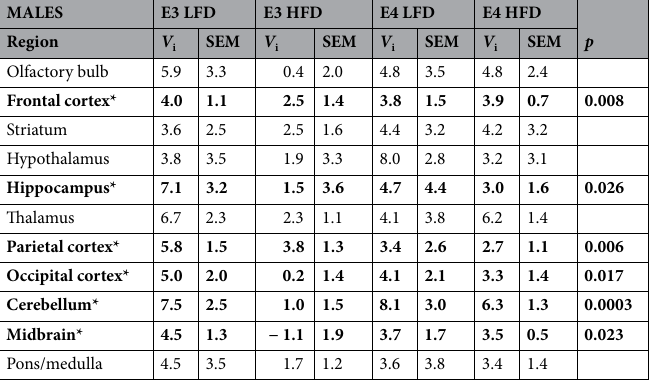
Table 1. 125 I-insulin regional vascular binding in males. Bold cells represent regions where * p < 0.05 between groups. V i : reversible vascular binding, SEM: ± standard error mean, p: significance between